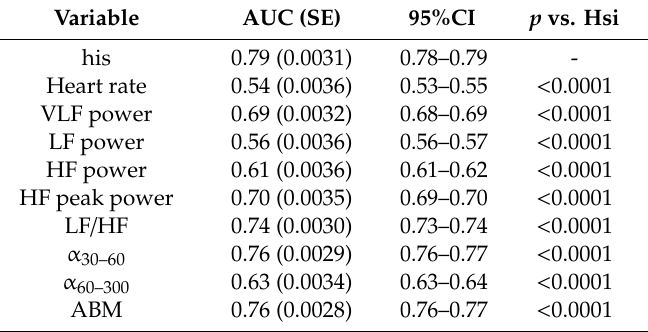
Figure 5. Receiver-operating characteristic (ROC) curves for discriminating NREM from wake and REM stages. AUC for Hsi is greater than those of other HRV indices, scaling exponents, and ABM and is comparable to that for the Hsi of respiration (Table 3). Table 4. Discriminant performance of NREM stage from wake and REM stages per epoch.